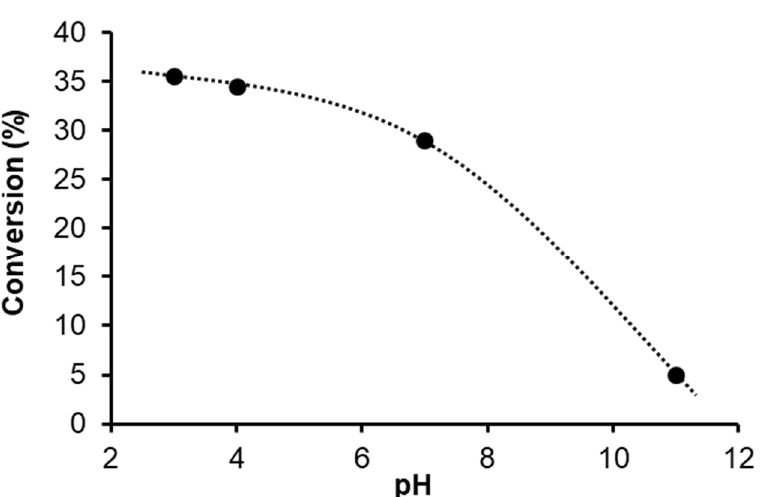
Figure 4. Conversion of phenylacetylene in hydrogenation catalyzed by [RuHCl(CO)( m tppms-Na) 3 ], 1 , as a function of the pH of the aqueous phase in water–1,2-DCE biphasic systems. Conditions: n(phenylacetylene) = 0.5 mmol, n(Ru) = 0.01 mmol, P (H 2 ) = 1 bar, T = 60 ◦ C, t = 2 h, V(aq. phosphate buffer) = 1 mL, V(1,2-DCE) = 1 mL. Analysis of the reaction mixture by gas